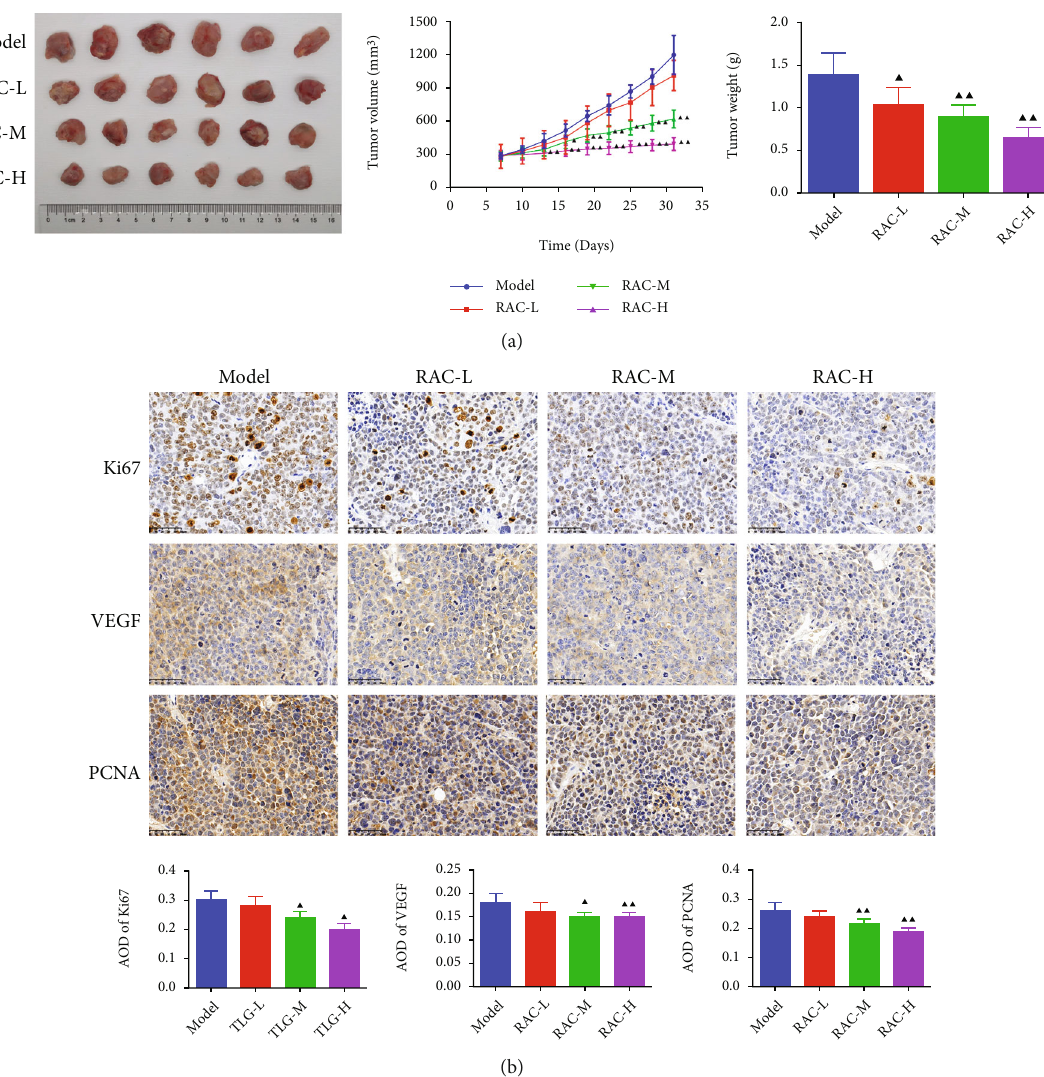
Figure 3: RAC inhibited the growth of tumors in RCC mice. (a) The volume and weight of the tumor. (b) The protein expressions of Ki67, VEGF, and PCNA were measured with immunohistochemistry. ▲ P < 0 : 05 and ▲▲ P < 0 : 01 vs. the model. Results were presented as mean ± SD . n = 6 or 3. Note: RAC: Radix Actinidia chinensis; RCC: renal cell